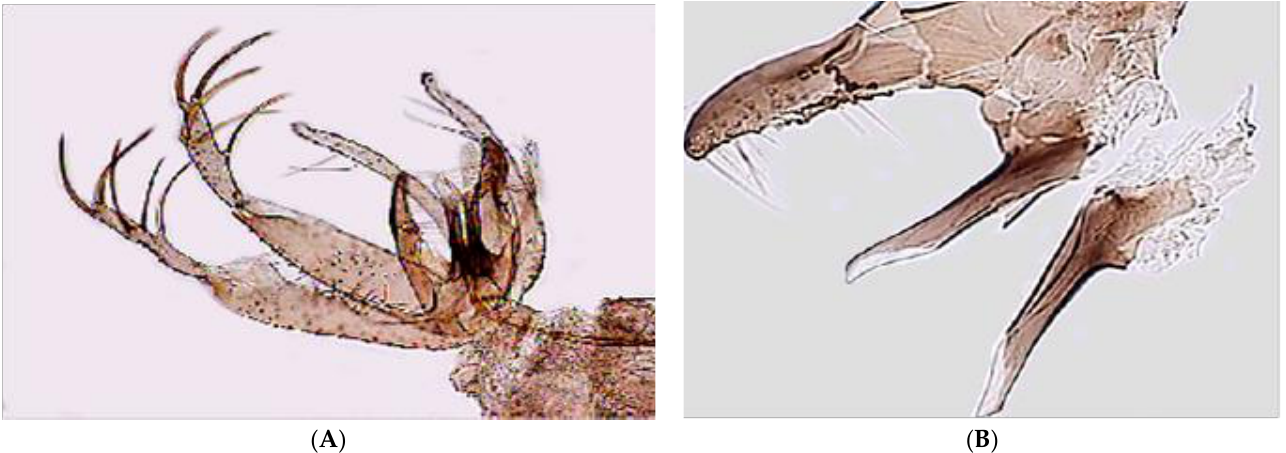
Figure 2. Photomicrograph of the genitalia ( A ) and parameral sheath ( B ) of Phlebotomus perfiliewi male.